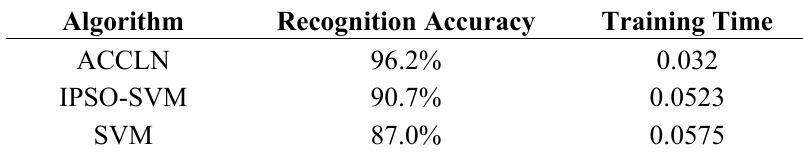
Table 2. Recognition accuracy of SVM, IPSO-SVM and